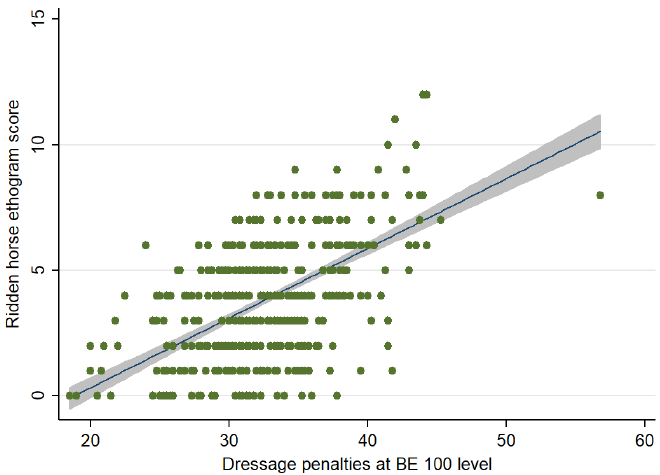
Figure 4. Comparison between the Ridden Horse Pain Ethogram (RHpE) scores and dressage penalty scores for competition starts at British Eventing 100 level ( n = 450). The green dots represent individual data points, the blue line is the best linear predicted fit and the grey area represents the correspond- ing 95% confidence interval. There was a moderate positive correlation (Spearman’s rho = 0.468, p < 0.001) between the RHpE scores and the dressage penalty